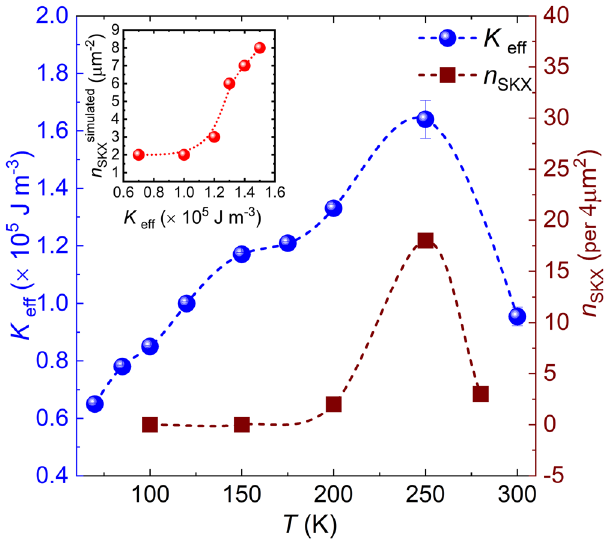
Fig. 5 Dependency of skyrmion density on effective magnetic anisotropy. Temperature variation of effective magnetic anisotropy constant ( K eff ) and number of skyrmions ( n SKX ) stabilized in tilted magnetic fi eld in each 4 μ m 2 area of the sample plate. The error bars in the K eff are calculated from the standard deviation of the fi tting parameters. The isolated skyrmion numbers up to 250 K are calculated for a fi eld of 0.32 T, whereas at 280K, the number is taken for the fi eld 0.2 T. The inset shows the number of simulated skyrmions ( n simulated SKX ) in constant tilted magnetic fi eld by varying the magnetic anisotropy (detailed simulation is given in the supplementary note